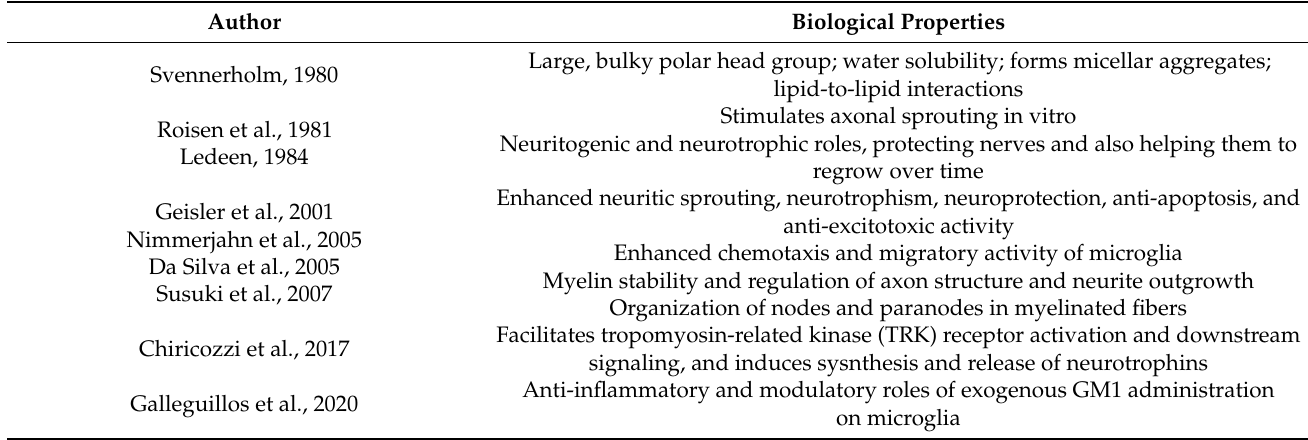
Table 2. Summary of main studies describing Sygen’s biological